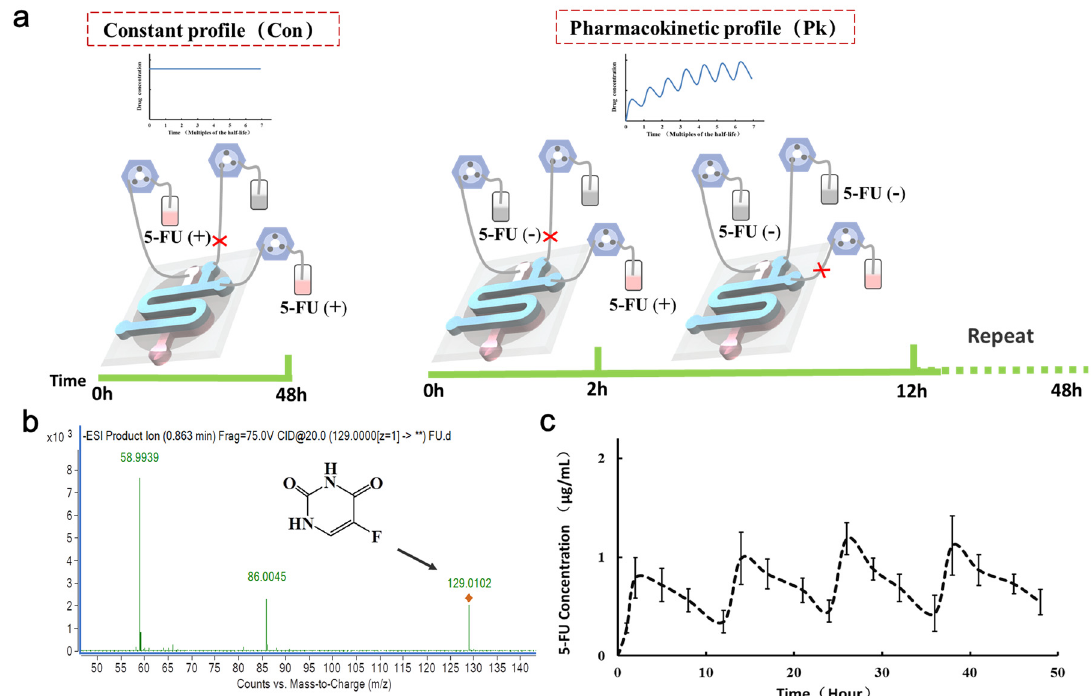
Figure 6. Modeling PK profiles of anti-cancer drug 5-FU administration in the microfluidic system. ( a ) Schematic drawing of two regimens of drug administration on chip. In the PK profile regimen (Pk group), 20 µ g / mL 5-FU exposed cells for 2 h was then withdrawn for 10 h, over a period of 12 h. In the constant profile regimen (Con group), 5-FU (20 µ g / mL) was continuously infused into the channel and treated cells for 48 h. ( b ) Detection of 5-FU peaks by mass spectrometry (MS) after treating cells with 5-FU for 48 h. ( c ) Characterization of concentration-time curve after treatment of cells with 20 µ g / mL 5-FU for 2 days.